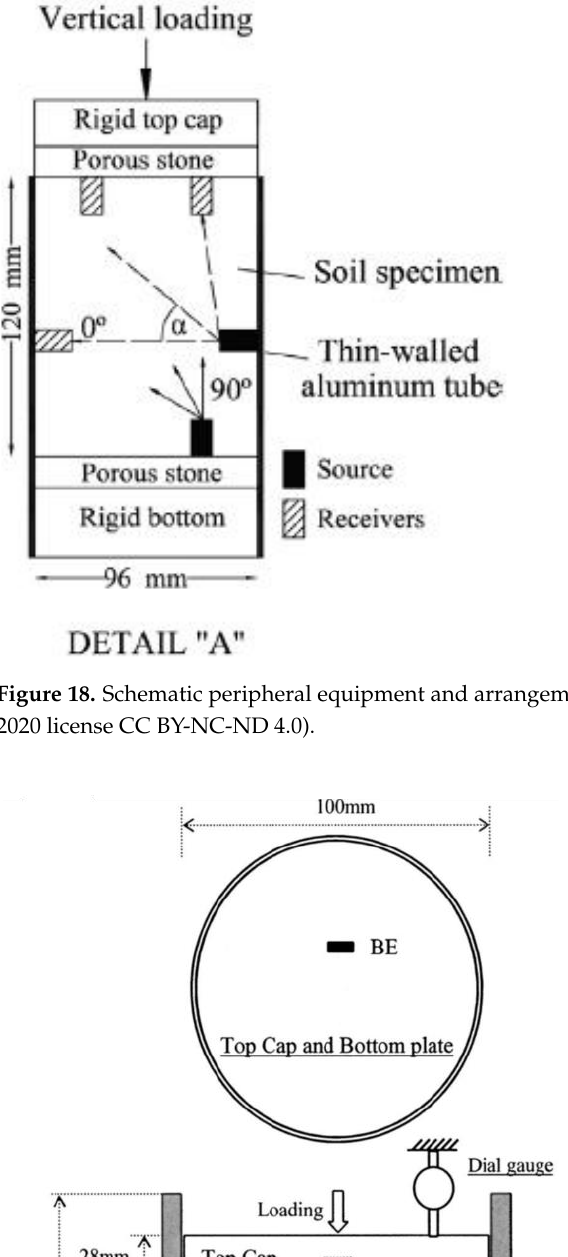
Figure 18. Schematic peripheral equipment and arrangement of bender elements [72] (available via 2020 license CC BY-NC-ND 4.0).